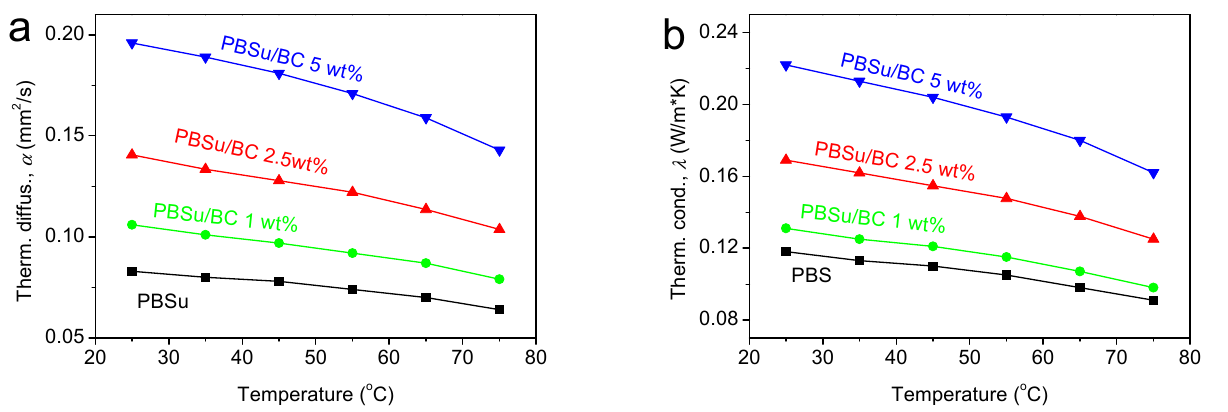
⁑ α and λ values correspond to room temperature. α and λ values correspond to room temperature.